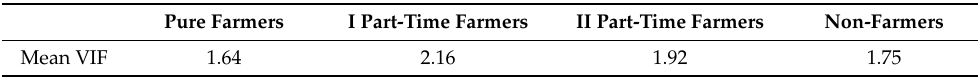
Table 6. Multicollinearity test